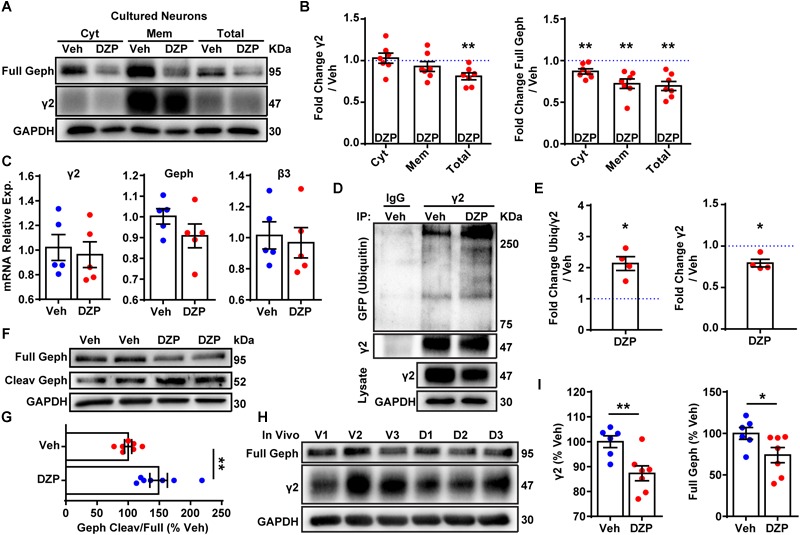
DZP induces degradation of γ2 and gephyrin in vitro and in vivo. (A) Cortical neurons exposed to 1 μM DZP or vehicle for 24 h were subjected to membrane fraction and western blot analysis. Full Geph = full-length gephyrin. (B) Total γ2 subunit and cytosolic, membrane, and total gephyrin were significantly reduced after DZP (n = 7 independent cultures). (C) Quantitative RT-PCR revealed no change in γ2 subunit, β3 subunit or gephyrin mRNA expression following 24 h DZP in vitro (n = 5 independent cultures). (D) GFP-ubiquitin transfected neurons were treated with vehicle or DZP for 12 h. Lysates were immunoprecipitated with control IgG or γ2 antibody, followed by blotting with anti-GFP, γ2 and GAPDH. (E) DZP treatment increased the levels of γ2 ubiquitin conjugates and decreased γ2 total levels. (F,G) DZP treatment enhanced the ratio of cleaved gephyrin fragments/full length gephyrin (n = 7 biological replicates/dishes from 4 independent cultures). Full, full-length gephyrin; Cleav, cleaved gephyrin. (H) Western blots of cortical tissue collected from mice 12 h after a single IP injection of 10 mg/kg DZP or vehicle. (I) γ2 subunit and full-length gephyrin levels are significantly reduced in DZP-treated animals (6–7 mice per condition). [∗p ≤ 0.05, ∗∗p < 0.01, paired t-test (B,E), Student’s t-test (C,G,I); error bars ± s.e.m].